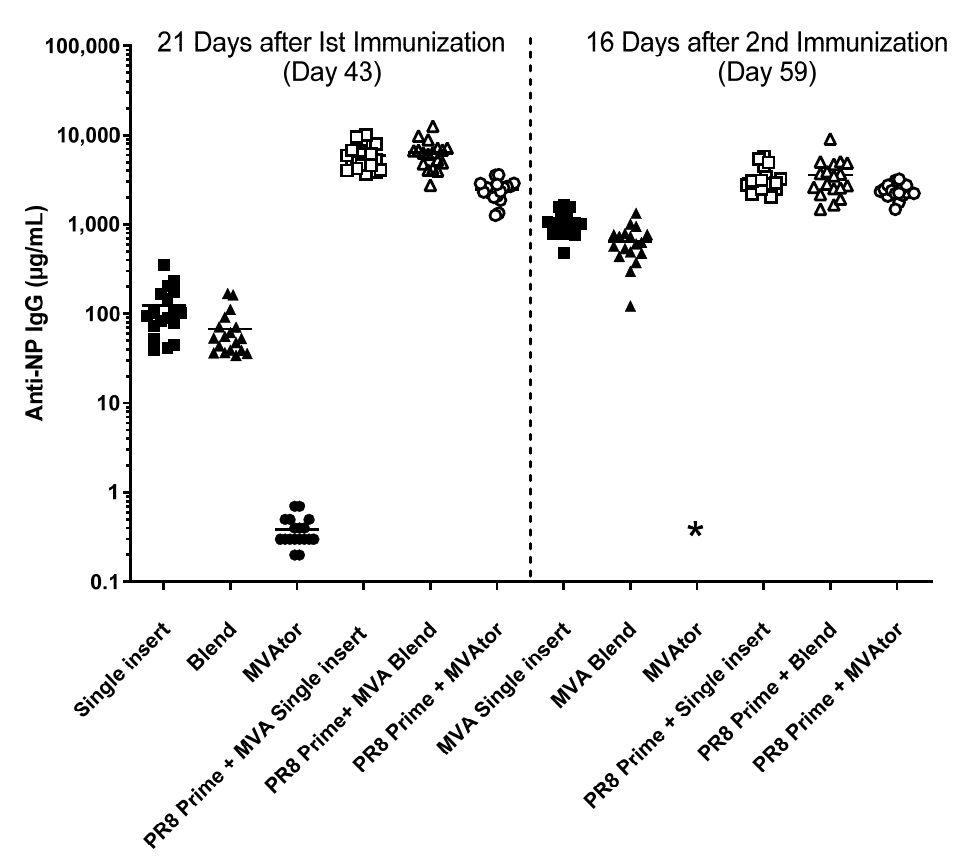
Figure 6. Levels of anti-NP IgG in sera of mice after vaccination with MVA vaccines that encoded NP combined with other antigens. Levels of serum anti-NP IgG were analyzed by ELISA. “Prime” refers to intranasal instillation of sublethal PR8 on day 0; first immunization using an MVA vaccine occurred on day 22; second immunization using MVA vaccines occurred on day 43. MVAtor alone did not result in serum anti-NP IgG antibody levels but priming using PR8 generated high IgG anti-NP levels. Squares depict single insert encoding M1 + METRC + NP; triangles depict a blend of individual M1, METRC and NP constructs; circles depict MVAtor controls. Filled symbols depict MVA vaccine treatments; empty symbols depict non-lethal (10% weight loss) PR8 infection as a priming event. * Anti-NP IgG ELISA were not performed using sera of this group.